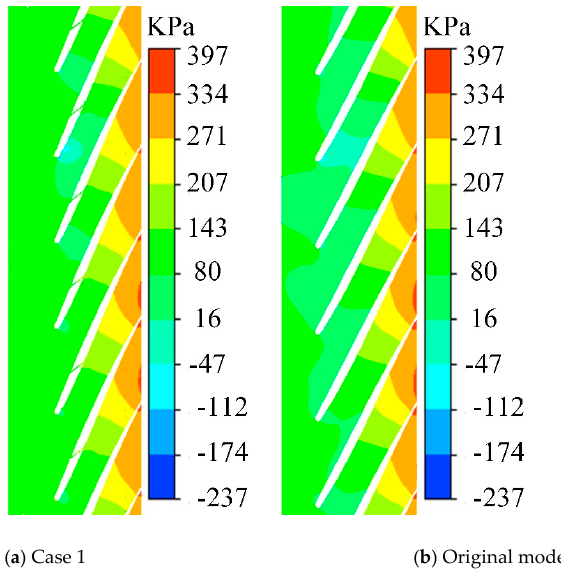
Figure 12. Static pressure distributions on the cross section of the impeller channel at 1.4 Q.